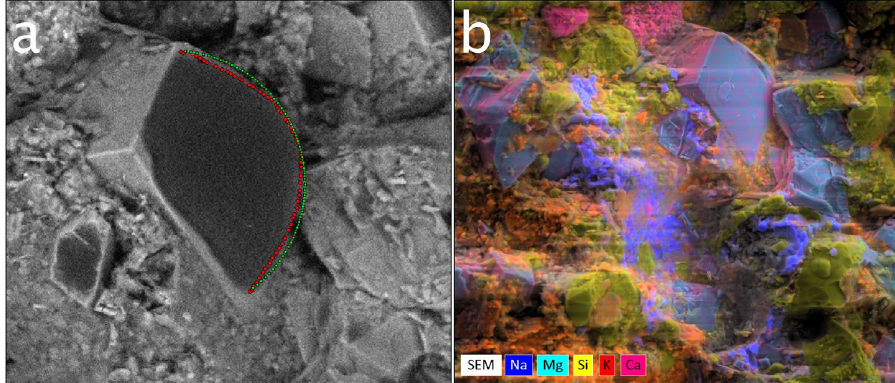
Figure 3. ( a ) A zoom-in of the dolomite crystal in Frame 4 of Fig. 2 illustrating 1) the extracted droplet profile (red dotted line) used for contact-angle assessment and 2) the fit of the parameterized Young-Laplace equation (green dotted line) used to estimate left and right contact angles, and droplet dimensions. The procedure for micro-droplet contact angle assessment is provided in the “Methods” section. The measured drop height and width is 17.1 μ m and 48.4 μ m, respectively. The right and left contact angles are 69° and 69°, respectively. ( b ) Elemental map (created from X-ray detection and analysis), superimposed on the secondary electron image of Fig. 2. The following minerals are interpreted from the elemental mapping: dolomite (determined from Mg, light blue), quartz (Si, yellow), potassium feldspar (K, red-orange), calcite (Ca, pink) and salt (Na, dark